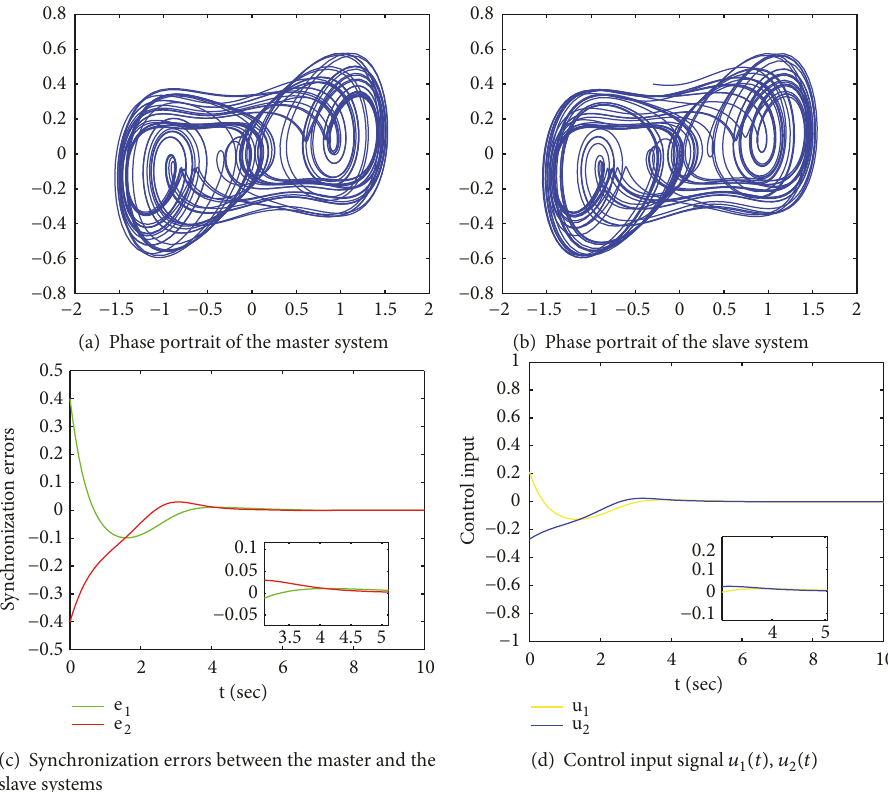
Figure 2: Behavior of the master-slave systems with control signal.